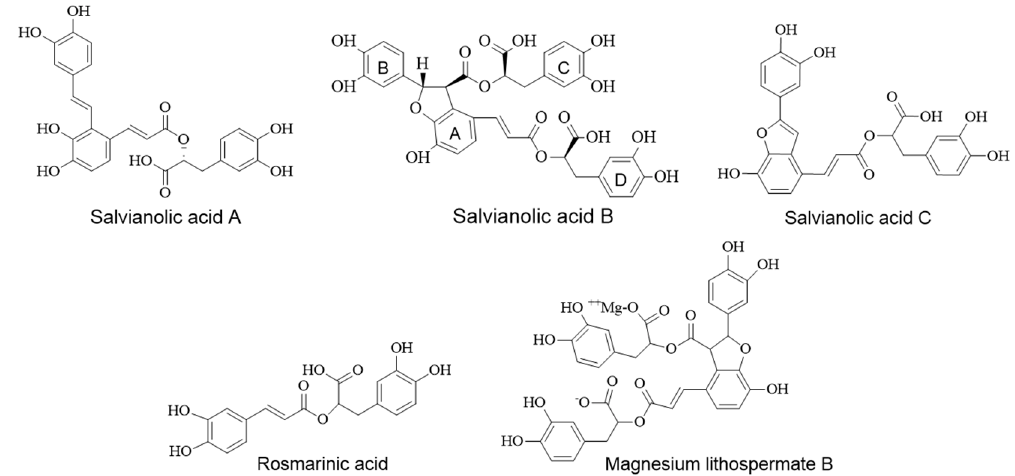
Figure 1. Structures of active polar components from S. miltiorrhiza.